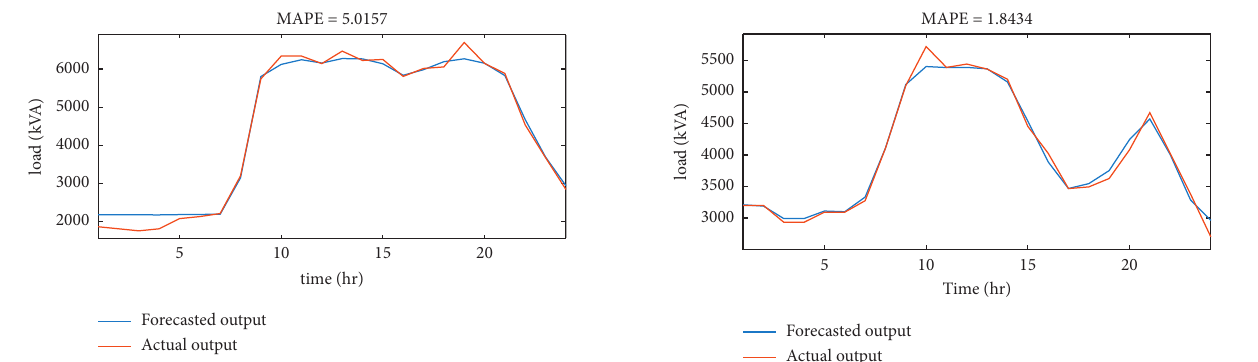
Figure 18: The Fuzzy-PSO prediction of Easter load.